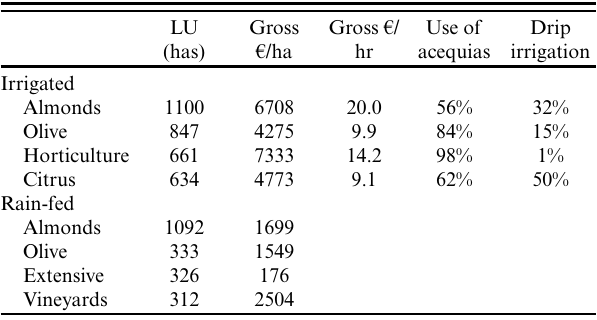
Table 5 . Irrigated and rain-fed crops. LU = land